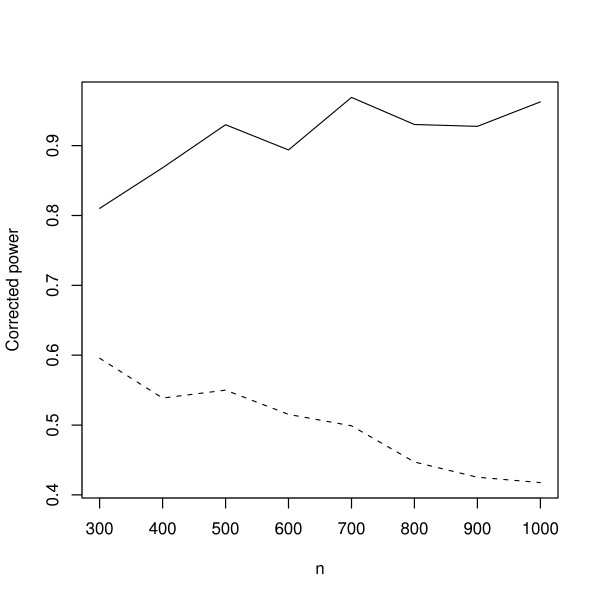
Corrected power curve. The full line represents the proposed OLS and the dashed line represents the standard OLS. It was performed 15,000 Monte Carlo simulations (model described in simulation I) for each n where n varied from 300 to 1,000 in steps of 100. n: sample size. P-value and standard deviation of measurement error were set to 0.05 and 0.5, respectively.